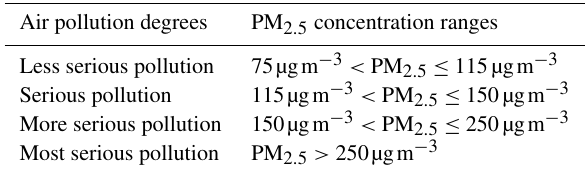
Table 1. Air pollution degrees categorized with surface PM 2 . 5 con-